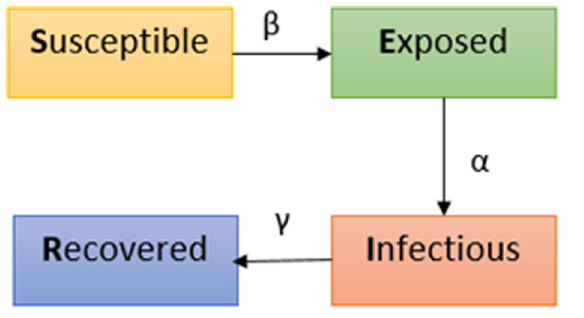
Fig 1. Schematic diagram of SEIR